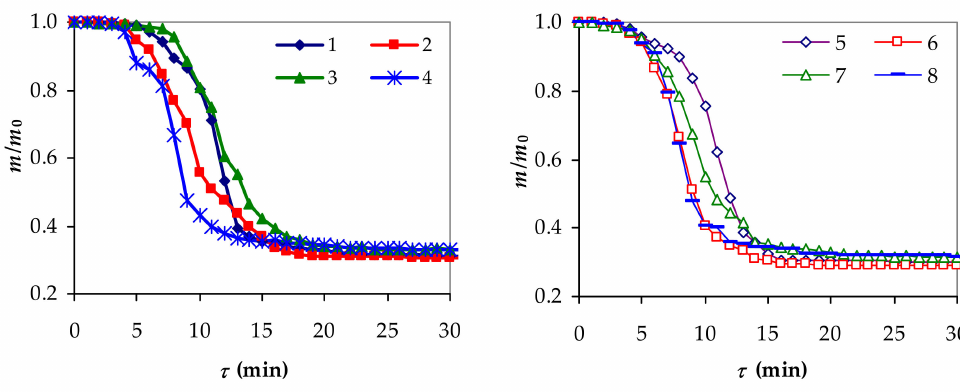
Figure 3. Specific mass of fixed bed vine waste vs. time.